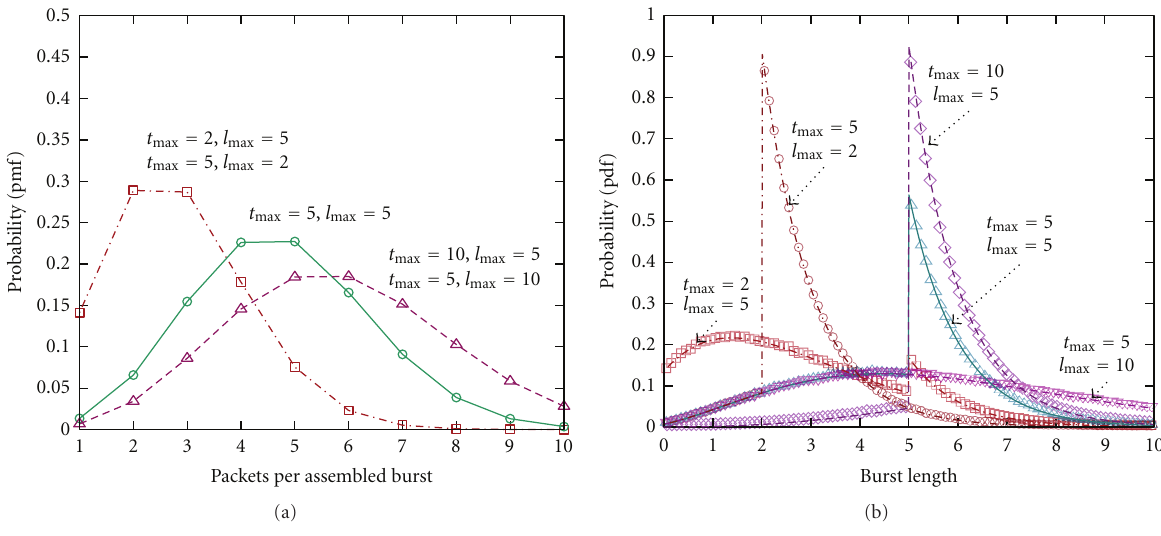
Figure 8: Hybrid burst assembly: distribution of packets assembled per burst and resultant burst length distribution.